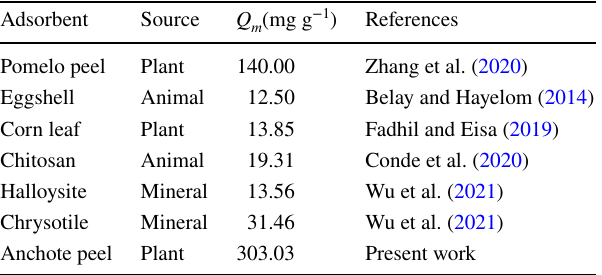
m ) of various adsor-